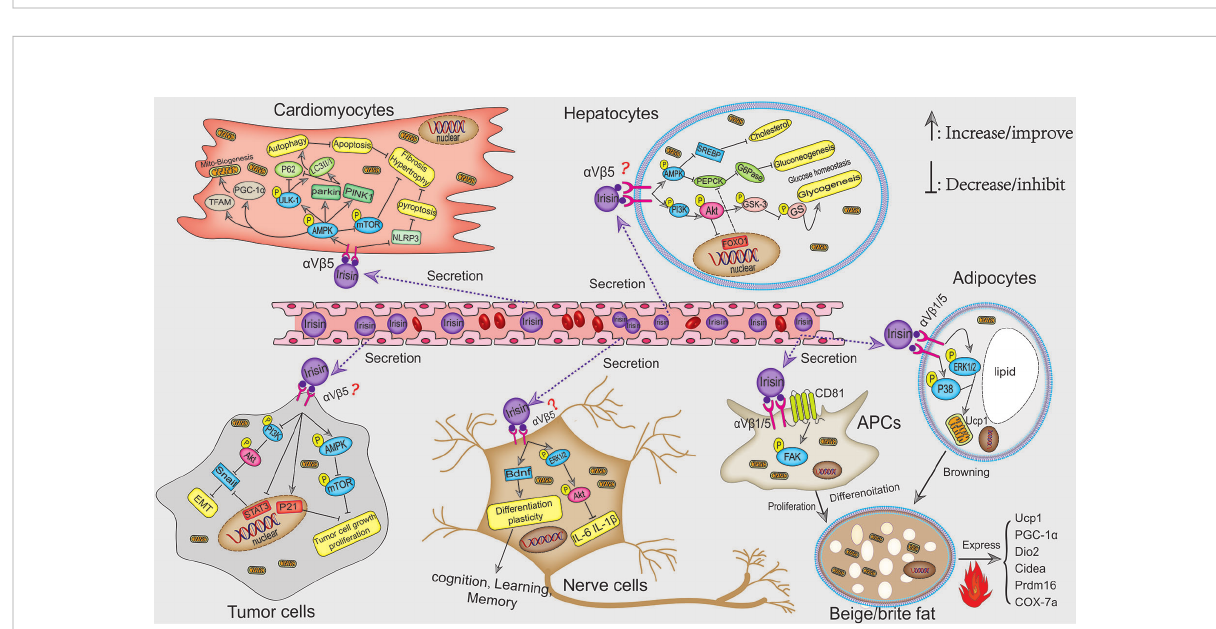
FIGURE 2 Potential mechanisms signaling pathways for the actions of irisin in the pathological tissues. Irisin protects against DIO by inducing the recruitment of beige fat to dissipate energy into heat. This mechanism is involved in p38 MAPK and ERK1/2 pathways, as well as FAK-mediated beige APCs proliferation. In addition, irisin attenuated diet-induced metabolic disorders, including NAFLD and hepatic steatosis by promoting the synthesis of liver glycogen via PI3K/Akt/GSK3-GS and inhibiting the generation of liver gluconeogenesis through AMPK-PEPCK/G6Pase and PI3K/Akt/FOXO1-mediated PEPCK/G6Pase pathways. In brain tissues, irisin promoted cognition and neuro development via inhibiting the in fl ammatory response and activating BDNF-mediated nerve cell survival, differentiation, and plasticity. Moreover, irisin affects the proliferation, migration, and invasion of tumor cells probably by binding integrin a V/ b 5 – mediated PI3K/Akt-Snail-EMT and AMPK-mTOR pathways, which has great therapeutic prospects for inhibiting cancer development. Moreover, exercise-induced irisin can also reduce the risk of cardiovascular diseases. In cardiomyocytes, irisin stimulated AMPK-mediated autophagy and mitobiogenesis by binding to its receptor integrin a V/ b 5, thereby relieving cardiac hypertrophy and